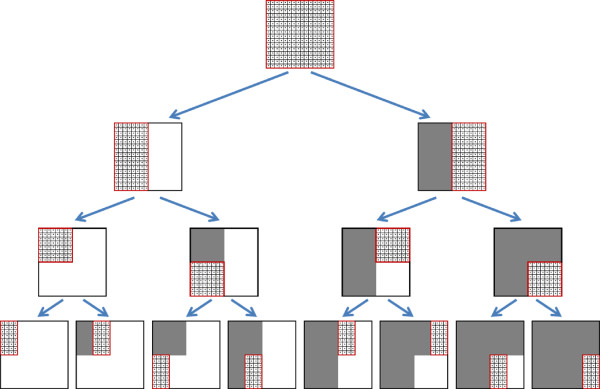
The tree of recursive calls to COMPUTE-MATRIX. Each call over a region containing more than one entry partitions the region either vertically or horizontally, and performs two recursive calls over the two sub-regions. After the first call was performed (the left or top sub-region for vertical or horizontal partition, respectively), a matrix multiplication involving the computed region is computed in order to meet the precondition required for the computation of the sibling region.